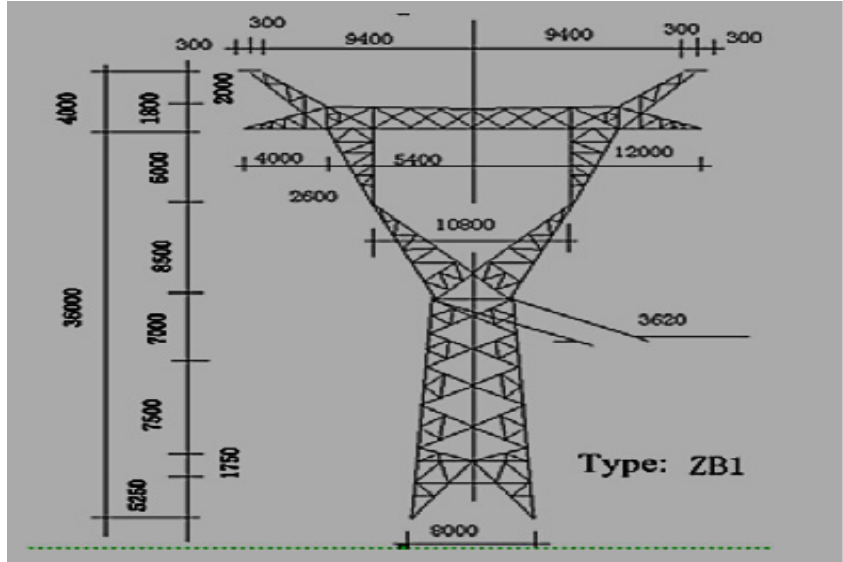
Figure 28. Structure of JG ‐ type tower [84].